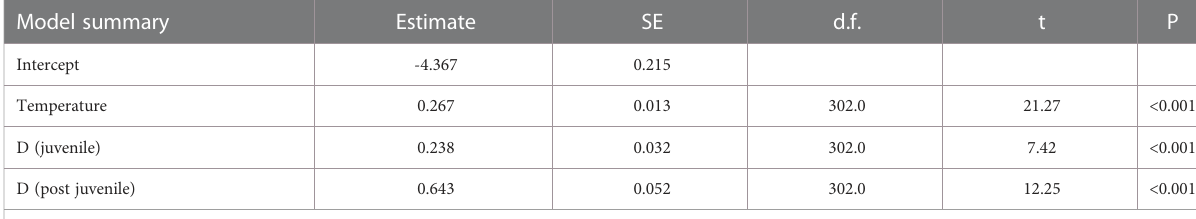
TABLE 7 Summary table for linear mixed effects model estimates fi tted using restricted maximum likelihood for the effect of temperature and developmental stage (D, larva, juvenile, post-juvenile) on growth rate of chub mackerel by 25 days post-hatch. Model summary